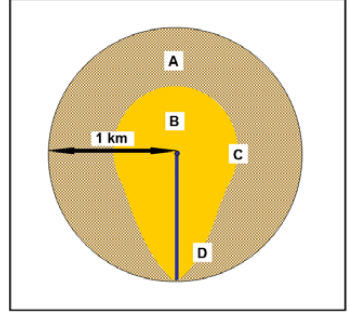
Figure 7. A hypothetical circular simple carbonate island made of eogenetic carbonate rock, 1 km in radius. Assume a 0.3-m dissolutional conduit drains the center of the island to the coast (vertical blue line). Meteoric water falling at A will have a diffuse flow pathway to the coast that is shorter than the diffuse flow pathway to the conduit (textured outer rim of the figure). Meteoric water falling at B will have a diffuse flow pathway to the conduit shorter than the diffuse flow pathway to the coast (solid inner part of the figure). The A and B waters will take different flow paths, with different flow characteristics, to the coast. Water at C and D is on the flow path distance boundary. The more efficient conduit flow path would be expected to create a trough in the freshwater lens that would draw water at C and D towards the conduit. The degree to which such a trough extends out into the rim of the island (texture part of the figure) depends on many variables: rock hydraulic conductivity, recharge rates and volumes, tidal forcing, etc.